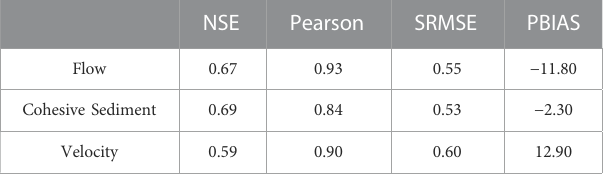
TABLE 9 Statistics indices for comparison.